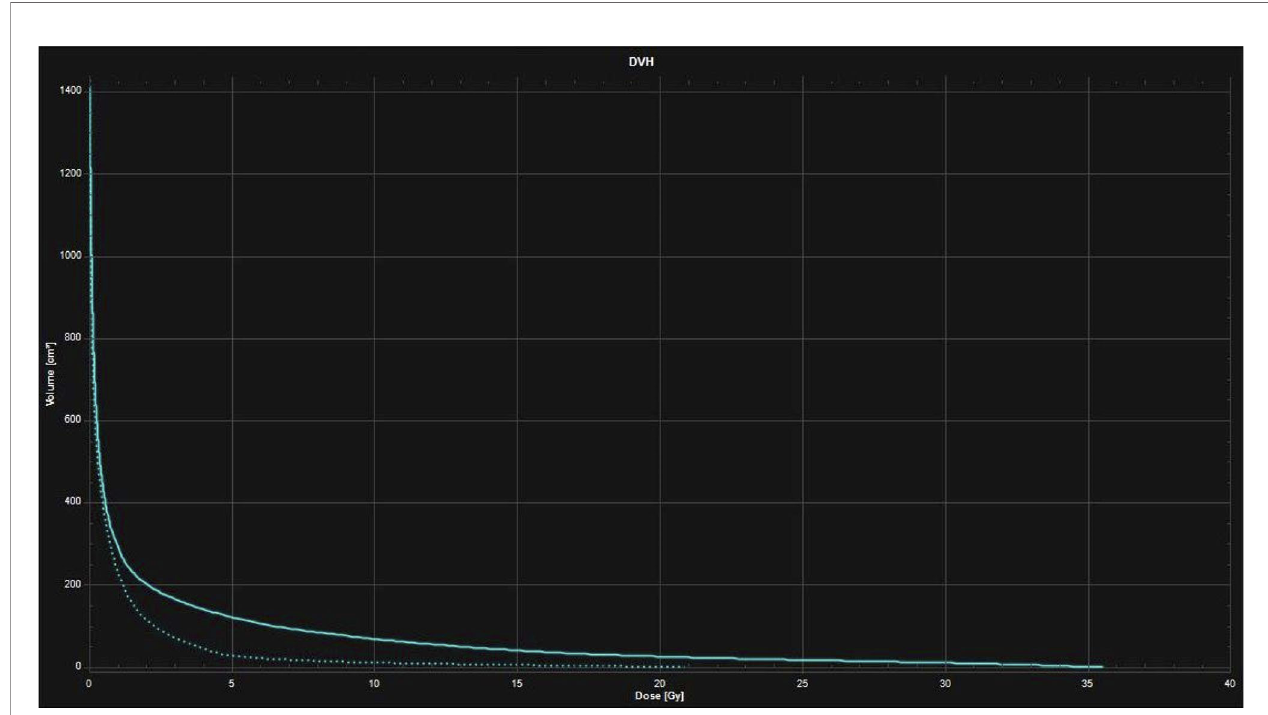
FIGURE 3 | Dose-Volume Histograms (DVH) showing the lower dose received by the healthy brain with the 16 Gy neoadjuvant SRS treatment plan (dotted line) compared to the 27 Gy in 3 fractions adjuvant SRT treatment plan (continuous